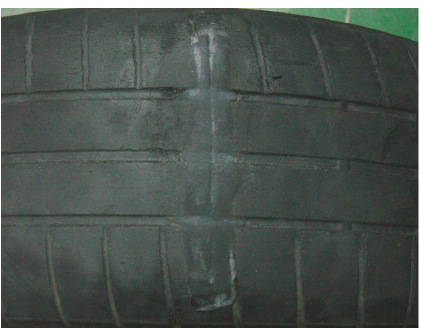
Figure 25. Defect repair. Figure 25. Defect